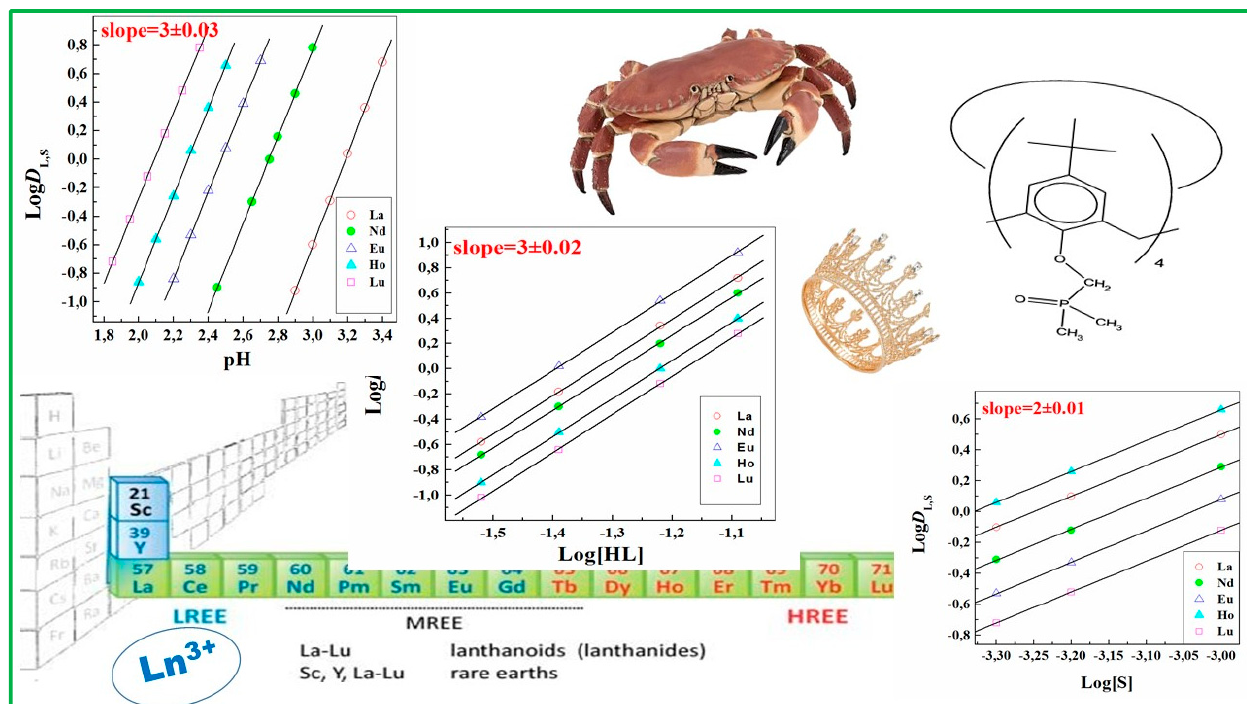
Figure 2. Log D L,S vs . pH for the extraction of lanthanoid ions with mixtures of HL(HTTA) − S at [HL] = 6 × 10 − 2 mol/dm 3 and [S] = 1 × 10 − 3 mol/dm 3 . Log D L,S vs. [HL] for the extraction of lanthanoid ions with mixtures of HL − S at [S] = 1 × 10 − 3 mol/dm 3 ; La, pH = 3.30; Nd, pH = 2.75; Eu, pH = 2.65; Ho, pH = 2.35; Lu, pH = 2.05. Log D L,S vs. [S] for the extraction of lanthanoid ions with mixtures of HL − S at [HL] = 6 × 10 − 2 mol/dm 3 ; La, pH = 3.35; Nd, pH = 2.85; Eu, pH = 2.50; Ho, pH = 2.50; Lu, pH = 2.05. Adaptation from Ref. [13] with